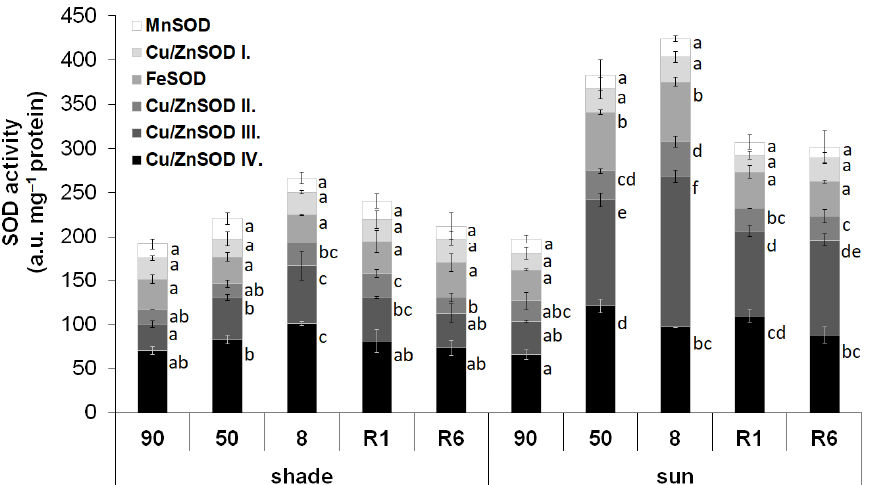
Figure 2. Stacked column plot of the activity of superoxide dismutase (SOD) isoenzymes in the leaves of shade and sun H. rhodopensis plants. Total SOD activity (represented by the total height of the columns) is divided into the activity of SOD isoenzymes based on native polyacrylamide gel electrophoresis. Activities were measured in controls (90% RWC) and during the stages of dehydration (50 and 8% RWC) and rehydration (1 and 6 days of rehydration; R1 and R6, respectively). To compare the differences within the corresponding isoenzyme activities, one-way ANOVAs were performed with Tukey–Kramer post hoc test on the SOD isoenzymes ( p < 0.05; n = 5).